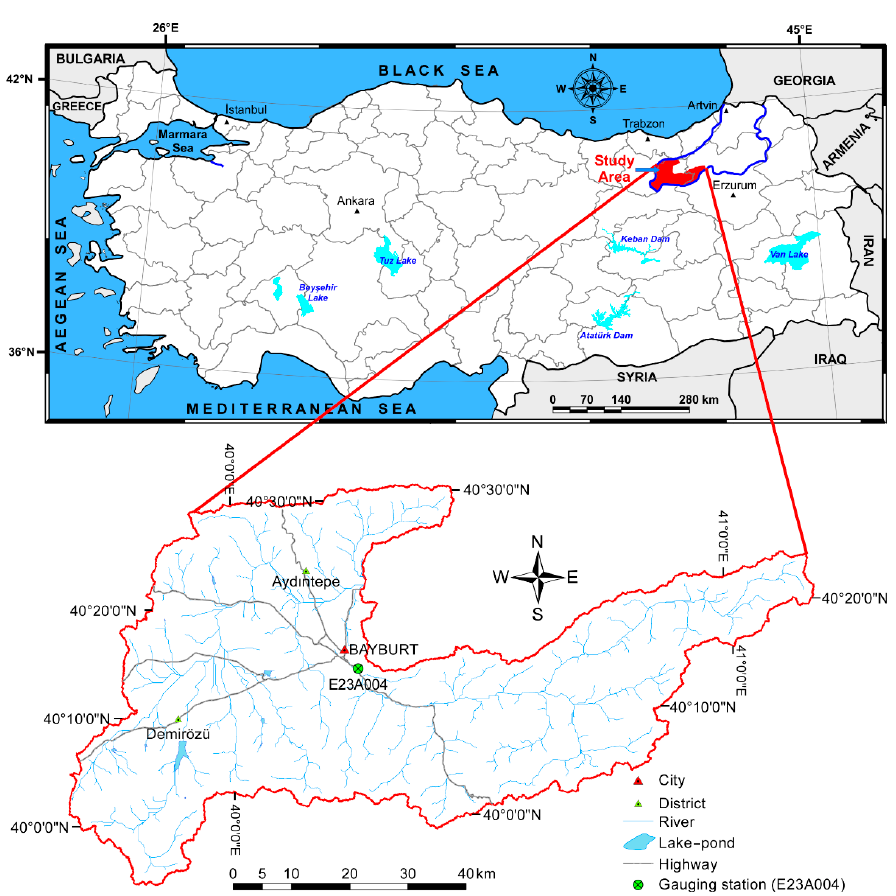
Figure 1. The Coruh River Basin location (the boundary is shown in dark blue colour) in the part of Northern Turkey and the extent of the Upper Coruh River Basin (UCRB) and the gauging station’s location. Provincial boundaries are shown in grey colour.